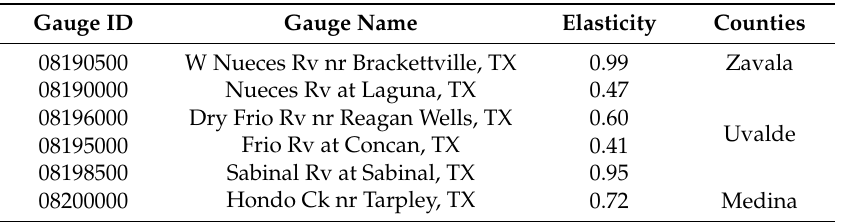
Table 5. Streamflow precipitation elasticity for each